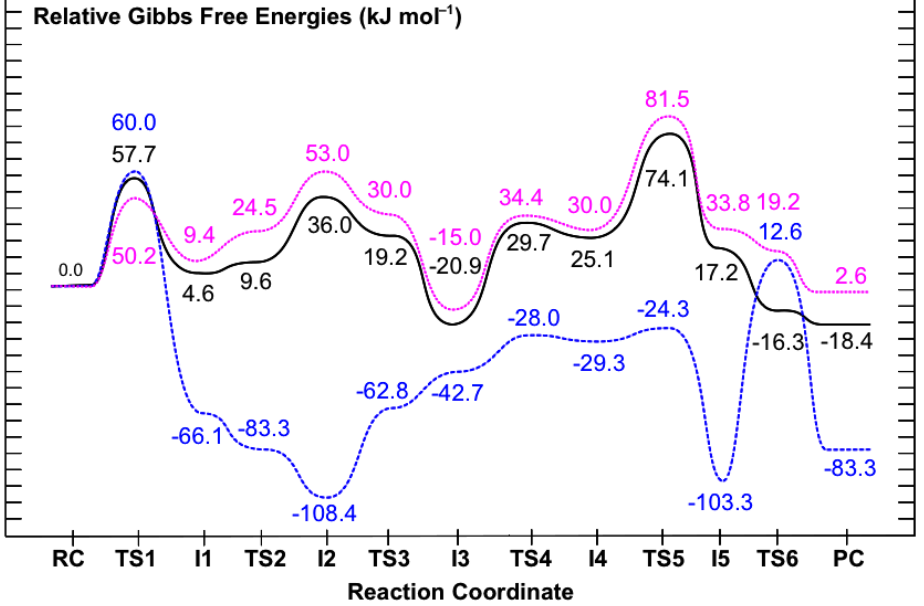
Figure 7. Overall PES’s obtained for the catalytic mechanism of saccharopine reductase at the (i) ONIOM(MP2/6-31G(d)//HF/6-31G(d):AMBER94)-ME + Gibb’s Corrections (dashed blue line), (ii) ONIOM(MP2/6-31G(d)//HF/6-31G(d):AMBER94)-EE + Gibb’s Corrections (dotted pink line), and (iii) ONIOM(MP2/6-311G(d,p)//HF/6-31G(d):AMBER94)-EE + Gibb’s Corrections (solid black line) levels of